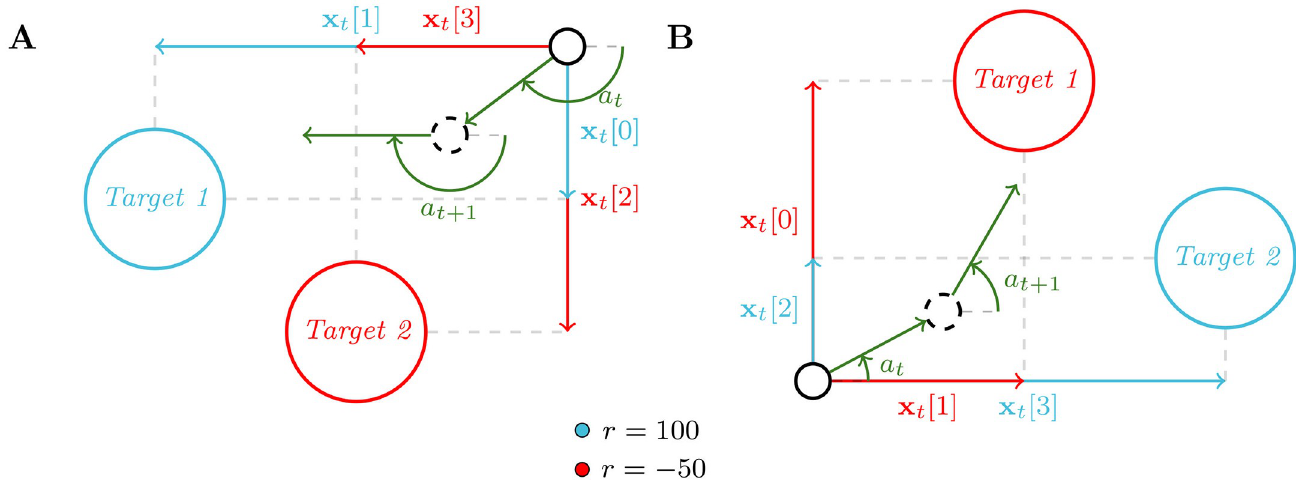
Fig 5. Sketch of a time-step interaction between an agent for the two different tasks M (A and B) sampled in D for the third benchmark. Each task is defined by the attribution of a positive reward to one of the two targets (in blue) and a negative reward to the other (in red). At each time-step the agent outputs an action a which drives the direction of its next move. If the agent reaches a target, it receives the corresponding